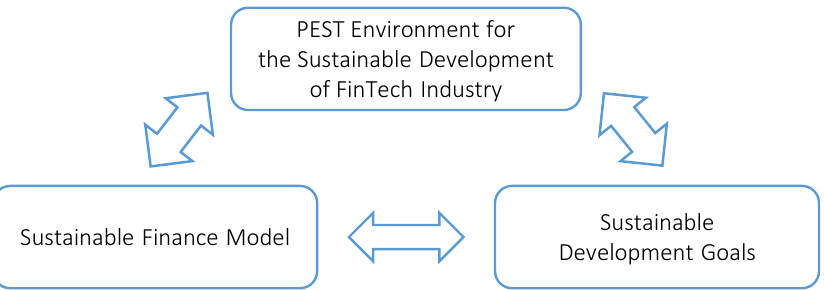
Figure 2. Link between FinTech PEST environment and four